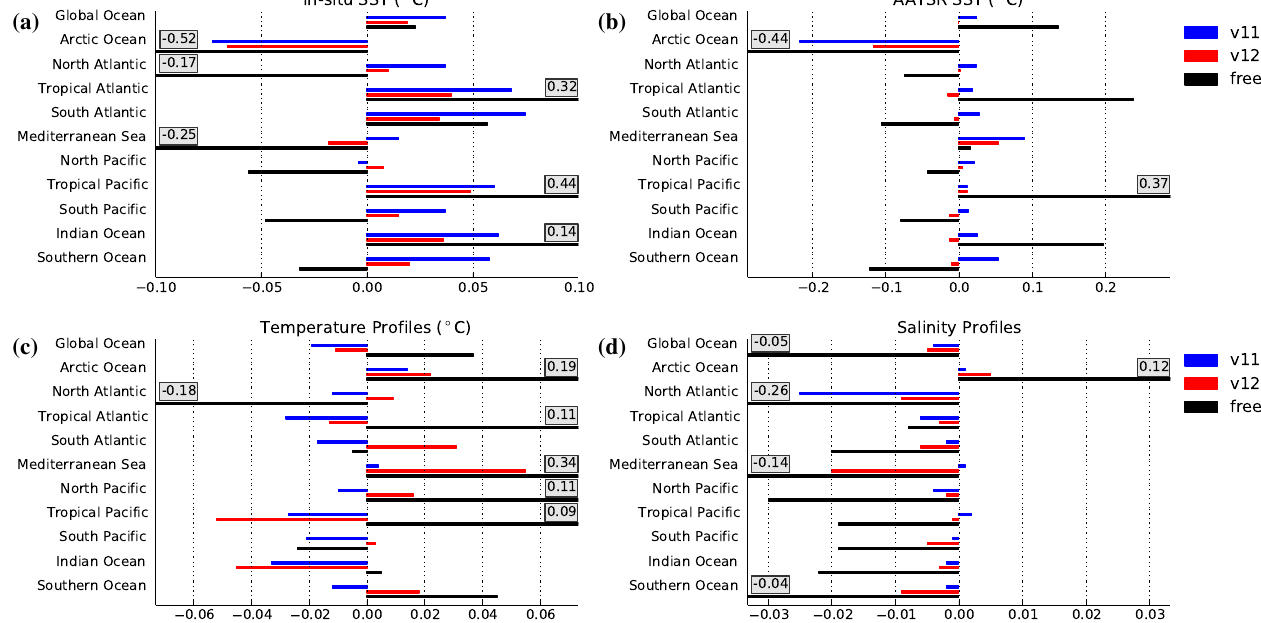
Figure 2. Mean errors against observations of (a) in situ surface temperature ( ◦ C), (b) AATSR satellite surface temperature ( ◦ C), (c) sub- surface temperature profiles ( ◦ C) and (d) sub-surface salinity profiles (measured on the practical salinity scale) for the v12 (red), v11 (blue) and free (black) trials. Mean errors are plotted as modelled–observed, meaning that positive temperature (salinity) values indicate that the model is too warm (salty). All statistics are compiled as averages over the full 2-year assessment period save for comparisons with AATSR data, which are only available until 8 April 2012. Where the mean errors for the free run are considerably higher than those for the assimilative runs, the x axis has been truncated in order to allow the reader to see the finer detail for the v12 and v11 runs. In these situations the mean error value has been added as an annotation above the corresponding bar.